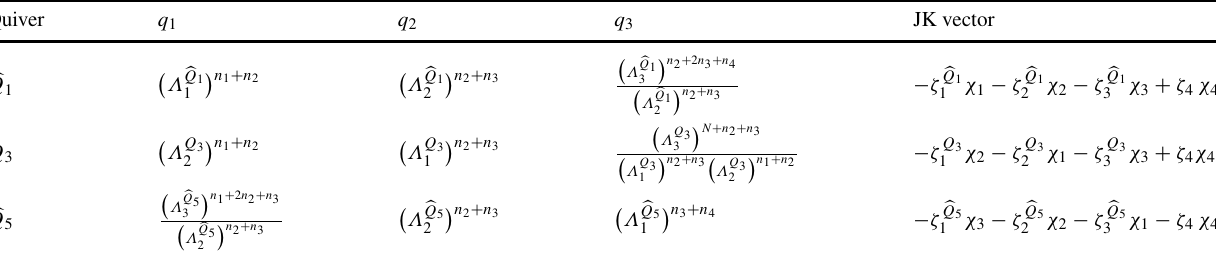
Table6 Forthequivers (cid:27) Q 1 , Q 3 and (cid:27) Q 5 drawninFig.9,welisttherela- that selects the contour prescription needed to compute the ramified tions (up to signs) between the ramified instanton counting parameters instanton partition function using the localization formula q I and the strong coupling scales Λ I , and also the JK reference vector Quiver JK